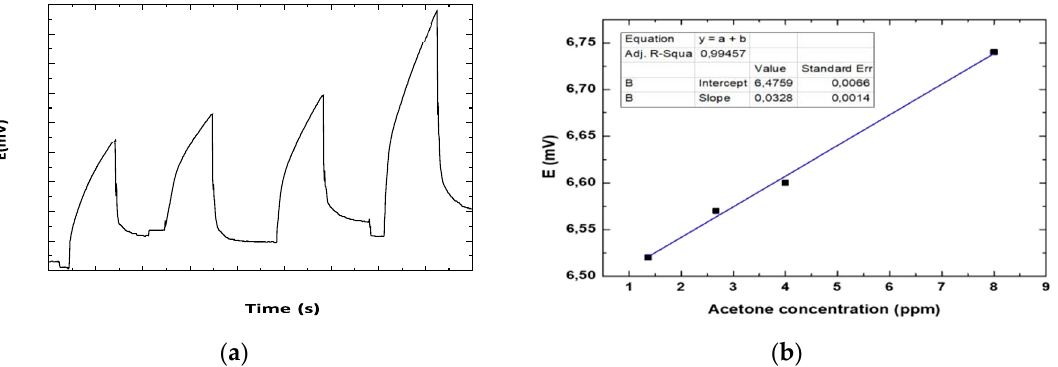
Figure 2. Measurement of change in Conductance in presence of Acetone in the gas surrounding the sensor using Lock-in amplifier: ( a ) Sensor response from lock in amplifier for acetone